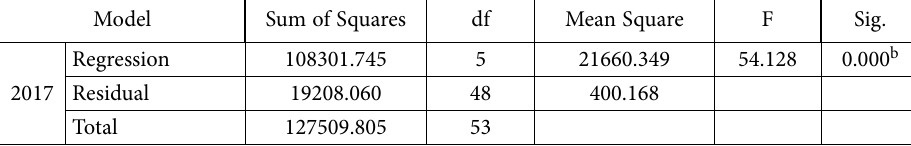
Table 8. ANOVA test of the model for 2017 Model Sum of Squares df Mean Square Sig.